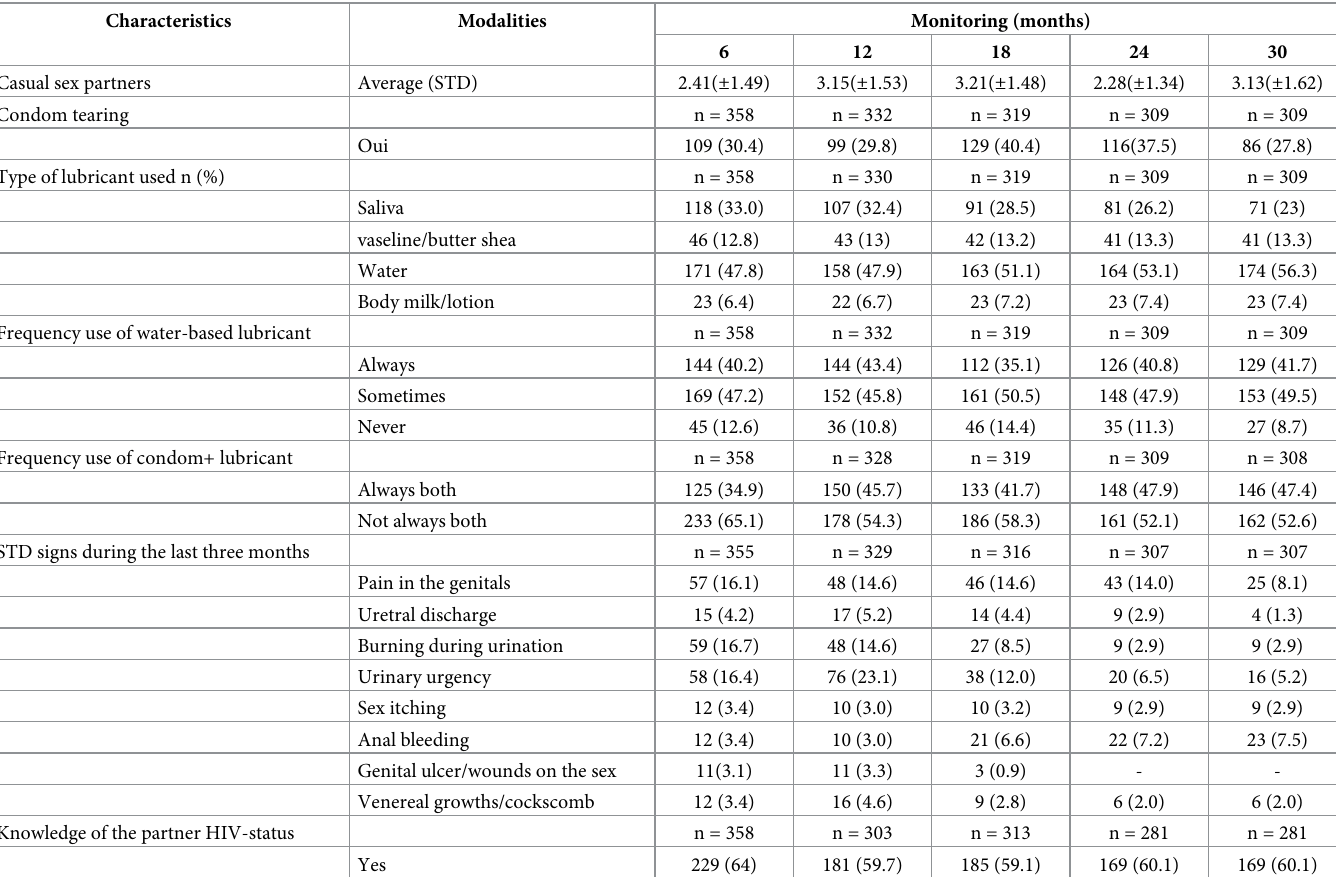
Table 2. Summary of HIV-infection risk factors among men who have sex with men during a 5-semester (30-month) monitoring period, Benin 2018. Characteristics